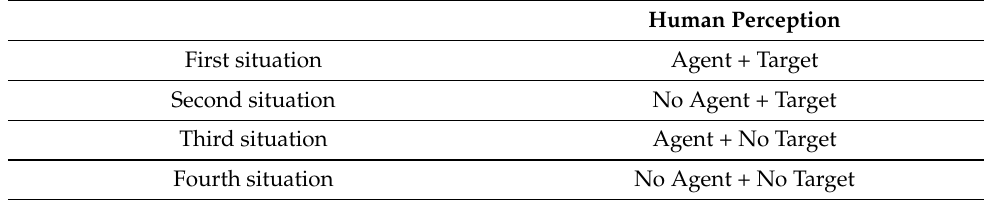
Table 1. Four situations of human